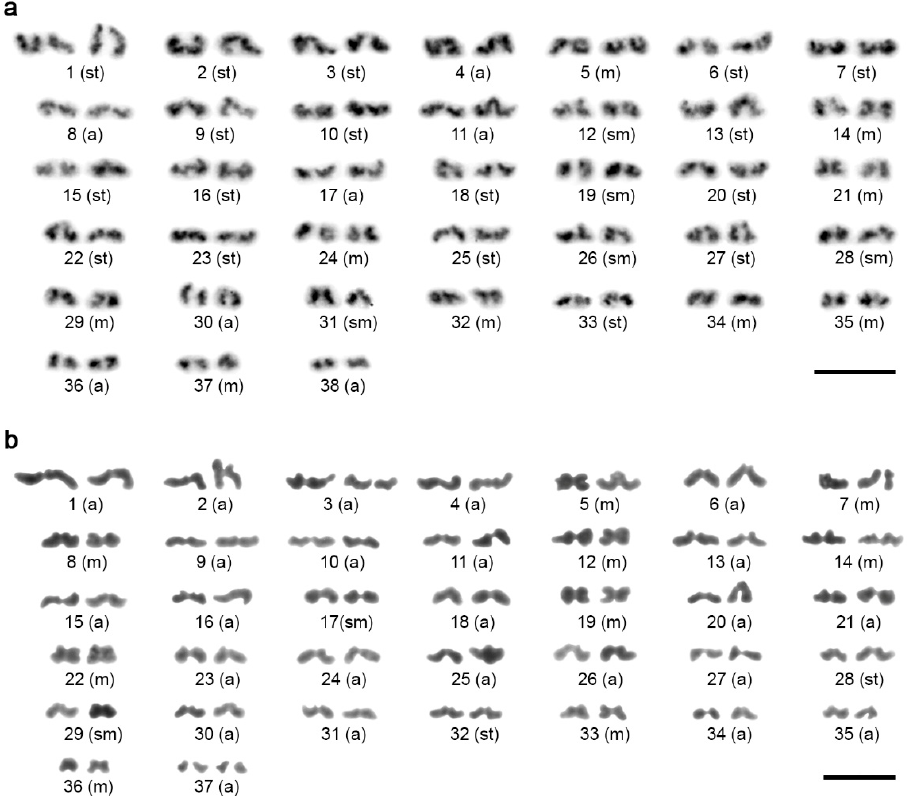
Figure 2. Male karyotypes of Charinus species II, Giemsa-stained. Karyotypes were constructed from two sister metaphases II. ( a ) C. cavernicolus (2 n = 76). ( b ) C. neocaledonicus (2 n = 74). Abbreviations: m = metacentric chromosome, sm = submetacentric chromosome, st = subtelocentric chromosome, a = acrocentric chromosome. Scale bar = 10 μ m.